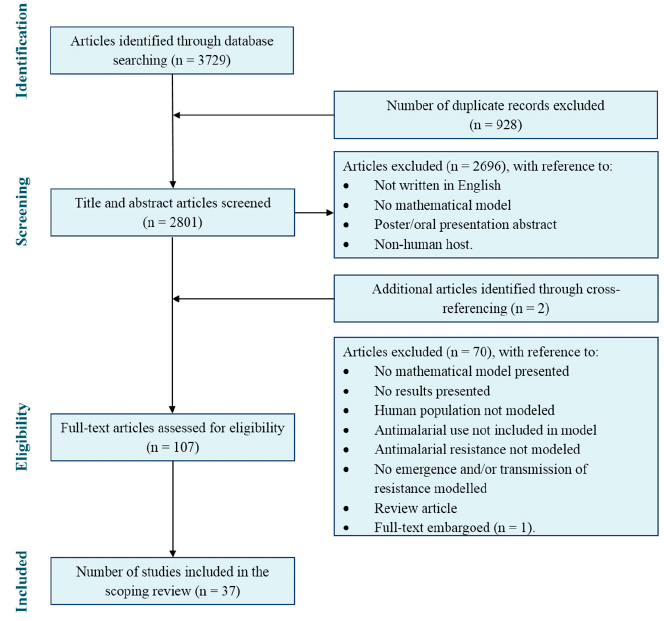
Figure 1. PRISMA flow diagram of the scoping review search and article selection.